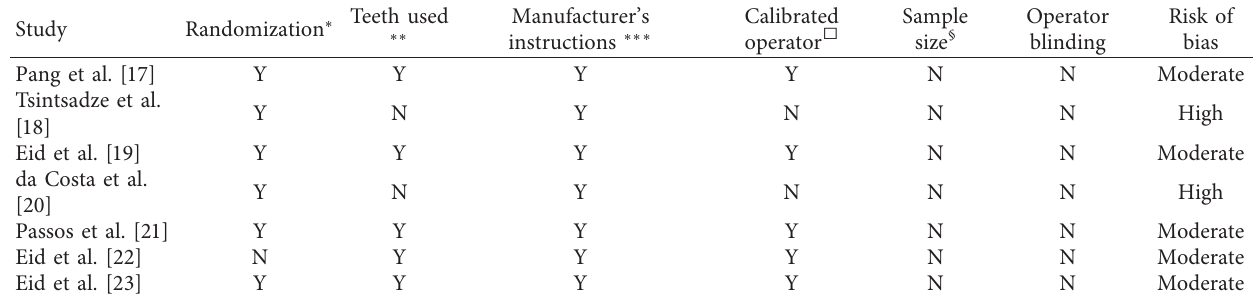
Table 3: Risk of bias according to the information evaluated from the materials and methods of the selected studies.